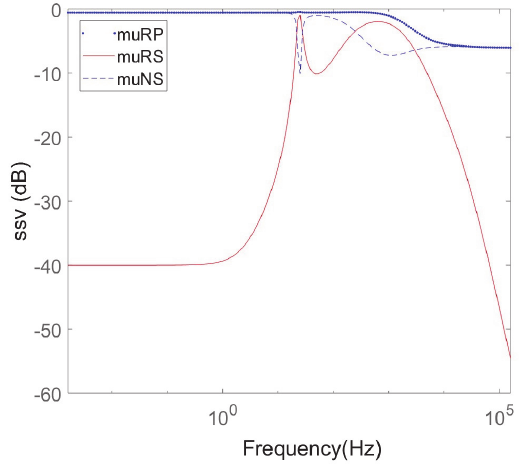
Figure 25. Performance curve.